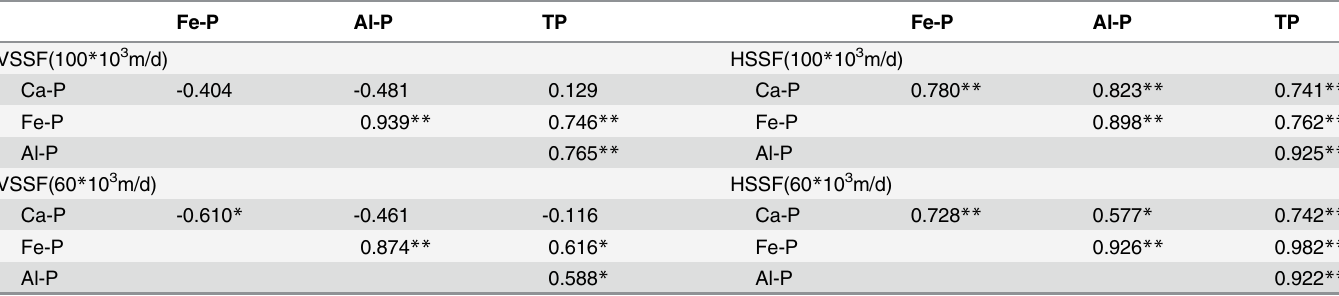
Table 3. Correlation between Ca-P, Fe-P, Al-P and TP in four CWs.